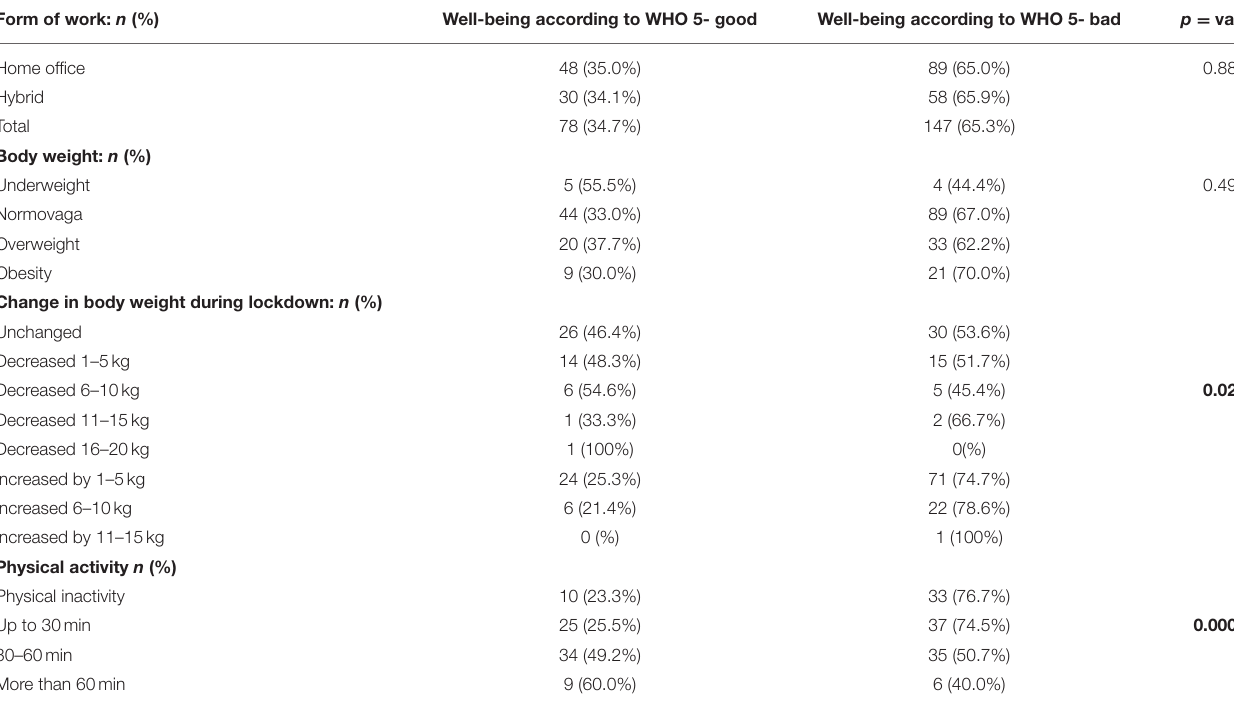
TABLE 6 | WHO well-being score − 5, and form of remote working, body weight, and change in body weight during lockdown ( n = 225). Form of work: n (%) Well-being according to WHO 5- good Well-being according to WHO 5-